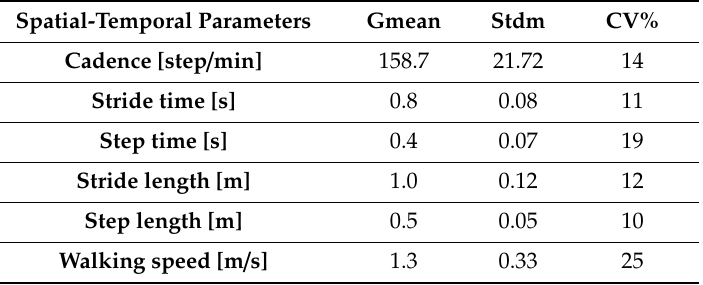
Table 2. Spatial-temporal parameters: grand mean, standard deviation of the means coe ffi cient of variation (CV%) over subjects and gait